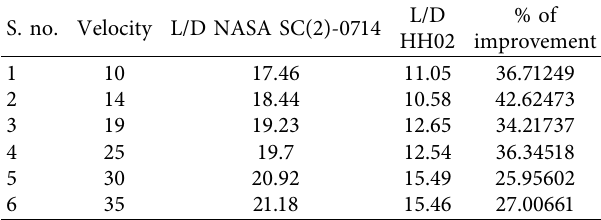
Table 7: Comparison of experimental aerodynamic efficiency.